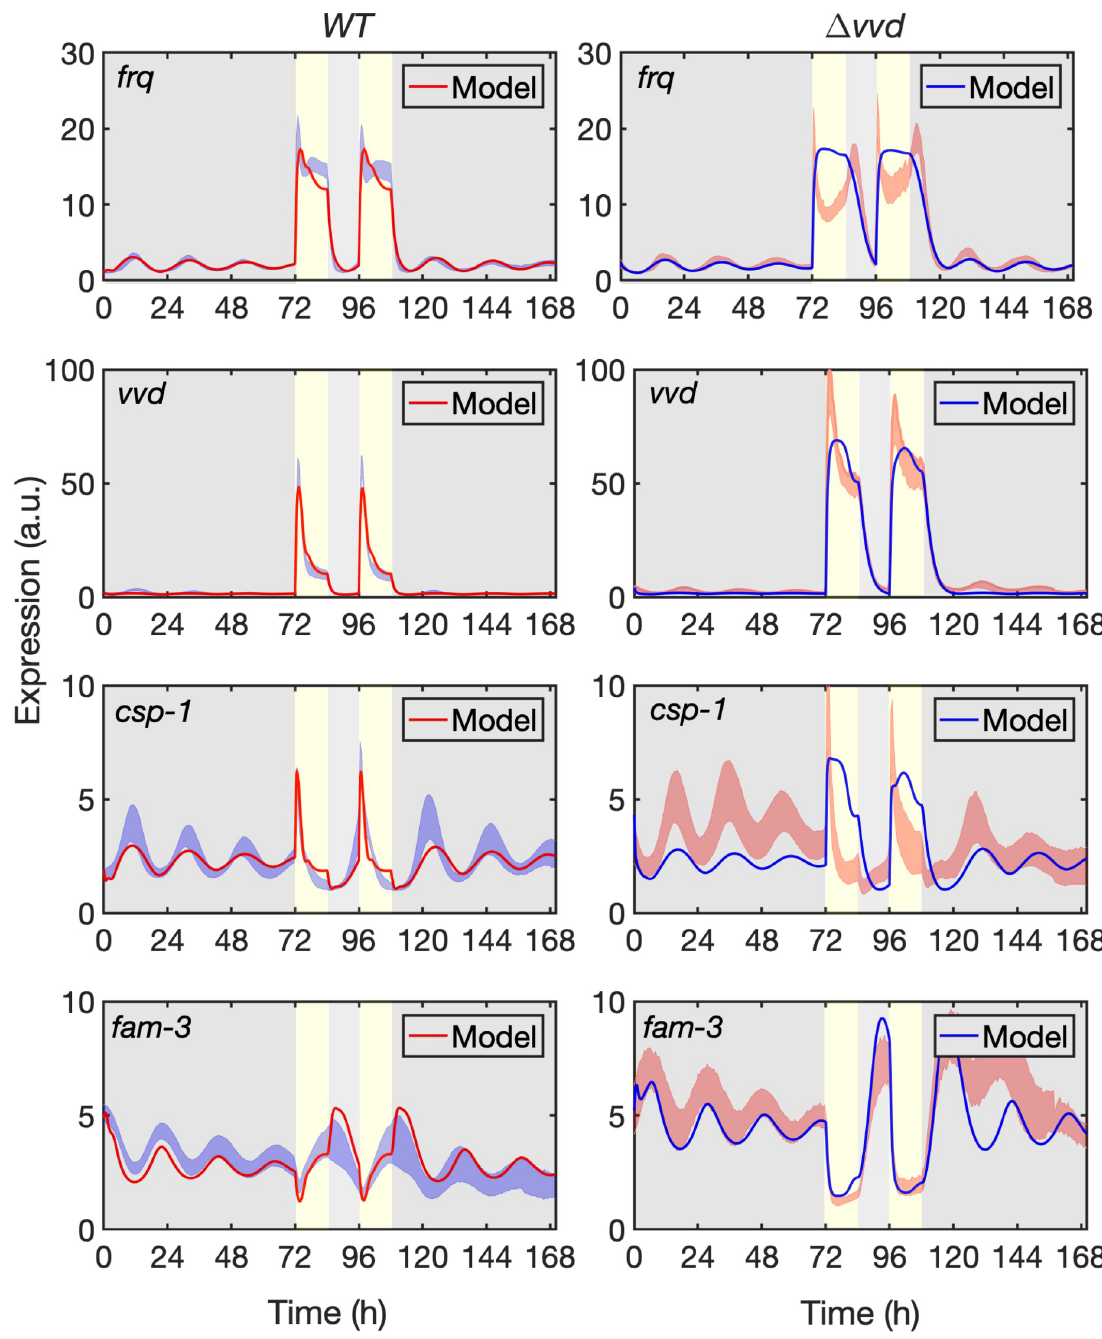
Fig 3. Model fitted to reporter gene expression in DD and